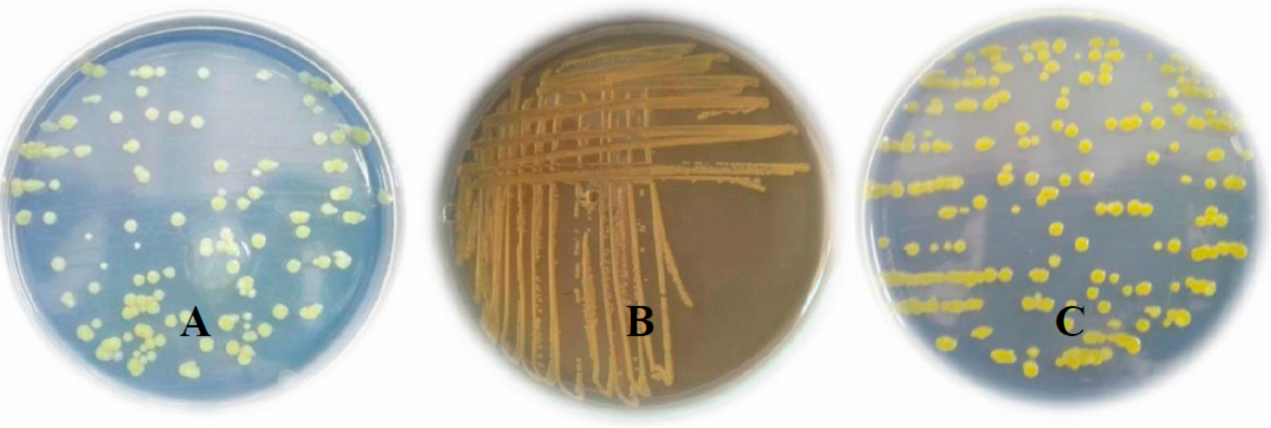
Figure 2. Colonial morphology on: ( A ) Nutrient agar medium, ( B ) Peptone Sucrose Agar (PSA) medium, and ( C ) Glycerol agar